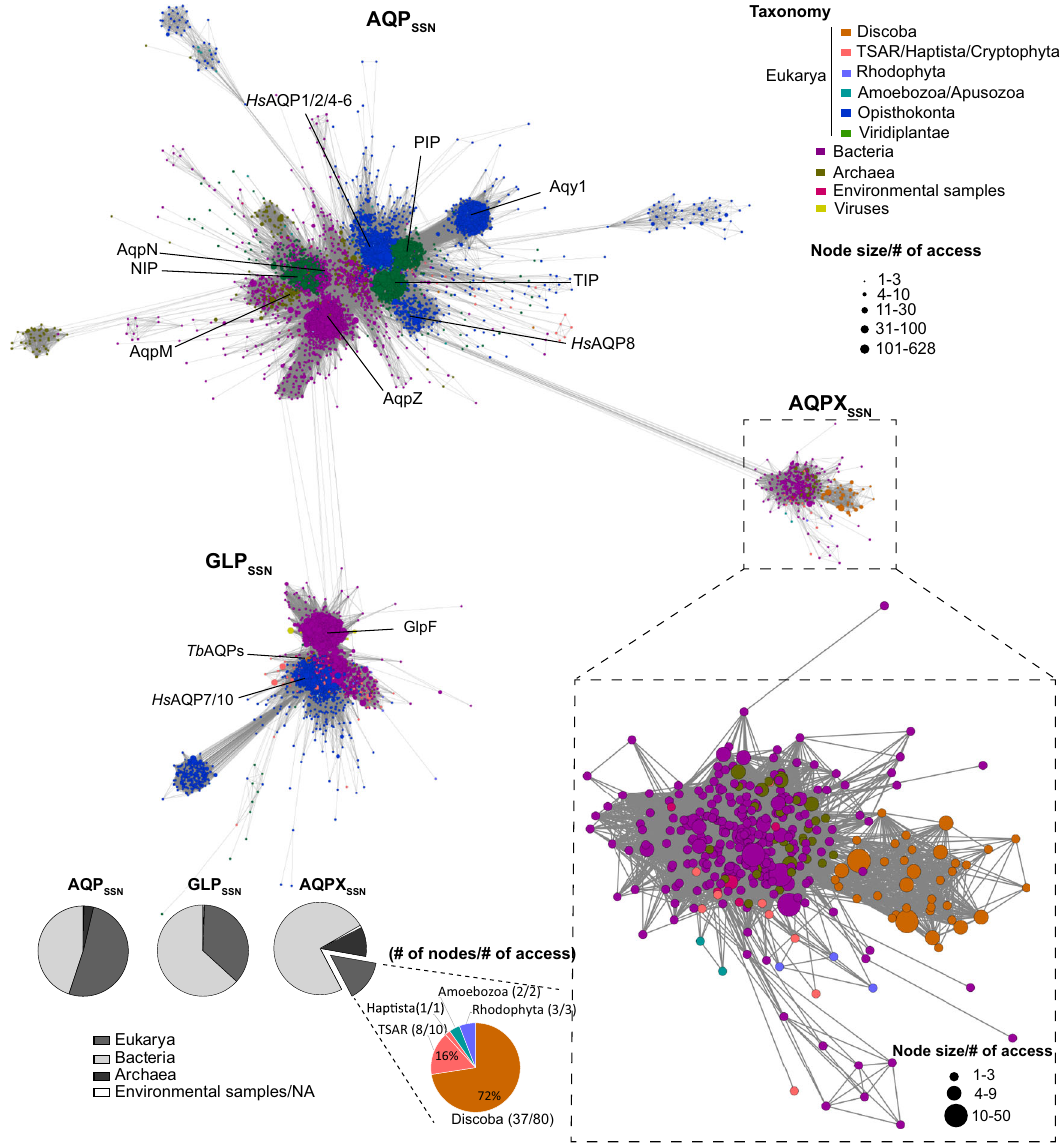
Fig. 2 Close up view of Cluster 1 of the Sequence similarity network (SSN). The cluster is composed of three main subclusters: AQP SSN , GLP SSN , and AQPX SSN . Kinetoplastid AQPs localize in the AQPX subcluster. Nodes are colored to distinguish among taxonomic groups. The node size re fl ects the number of accessions that are grouped with 85% identity in that node. The pie charts show the taxonomic composition of each subcluster according to the three-domain